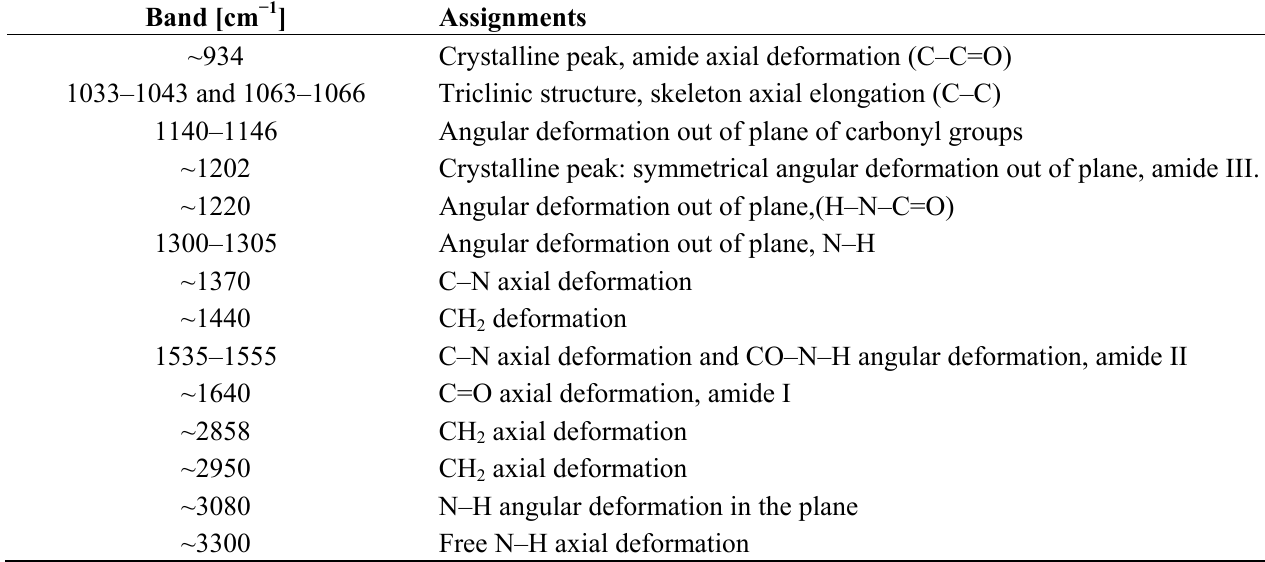
Table 2. Fourier transform infrared spectroscopy (FTIR) band assignments in Nylon 6,6